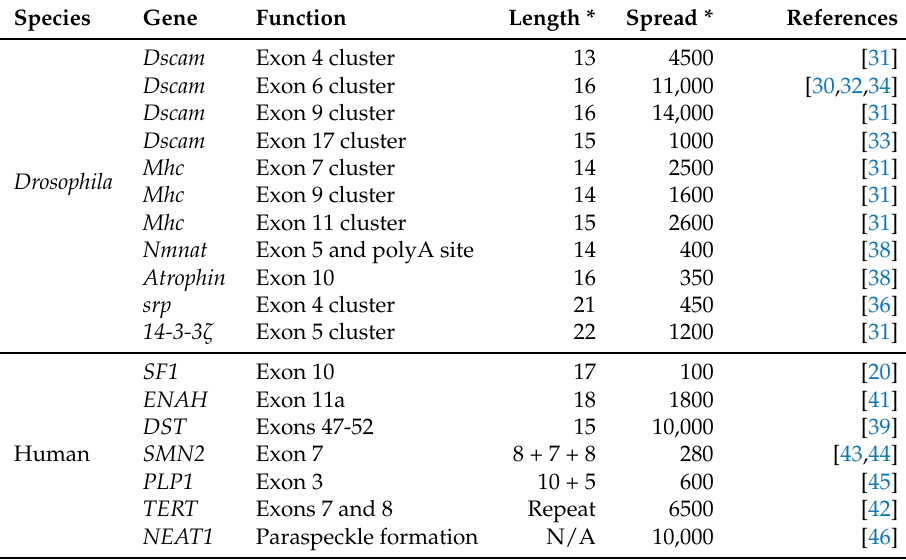
Table 1. Functional long-range RNA structures in Drosophila and